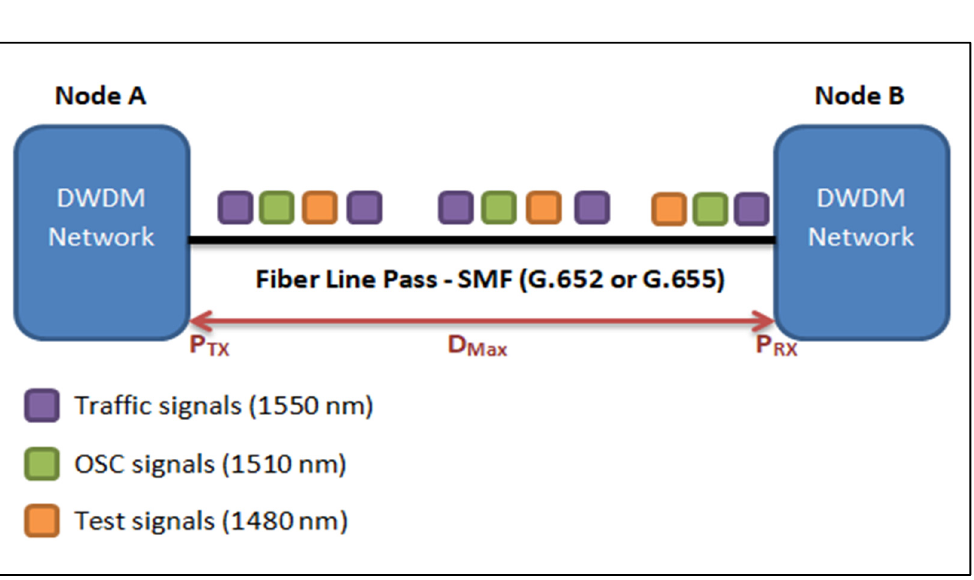
Figure 7. All the signal flows over the fiber line and the maximum distance to transmit the signal between two nodes. between two nodes.